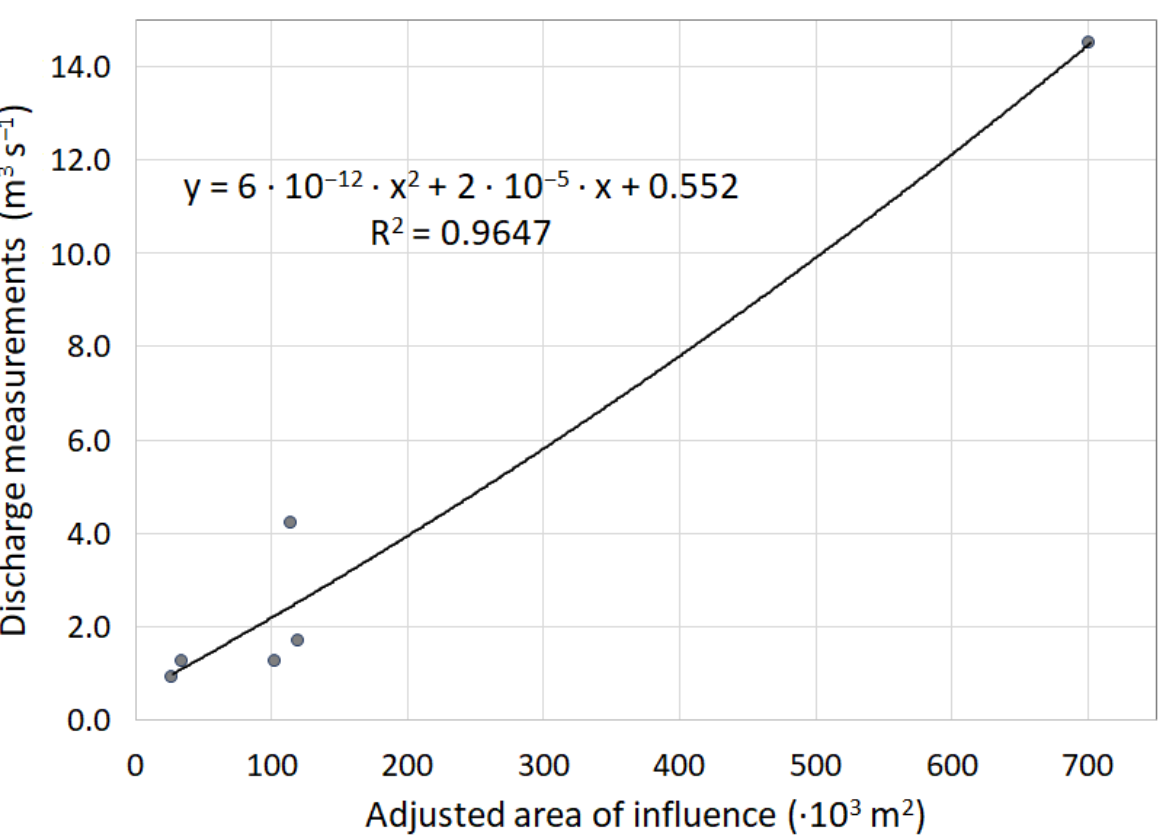
Figure 5. Correlation between adjusted area of influence and discharge measured at the Rje č ina’s